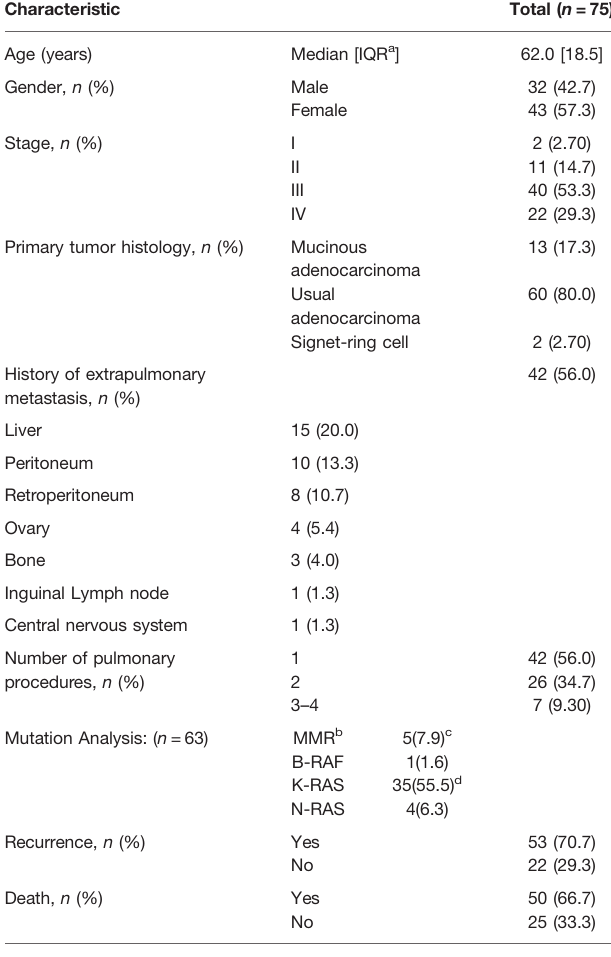
TABLE 1 | Demographic and clinical